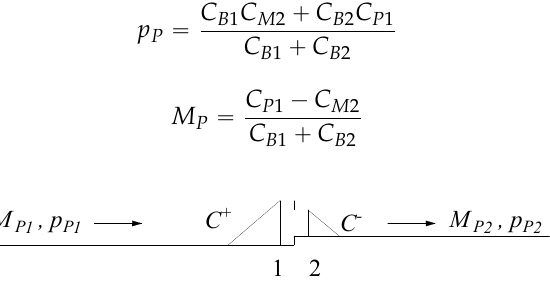
Figure 4. The boundary condition of pipes in a series.